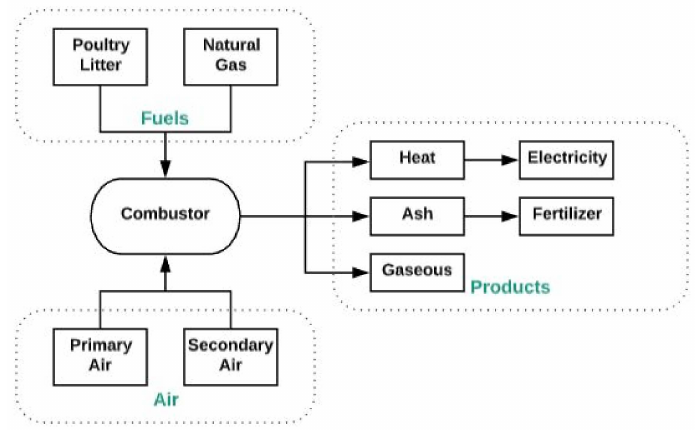
Figure 2. Flow chart of the poultry litter co-combustion